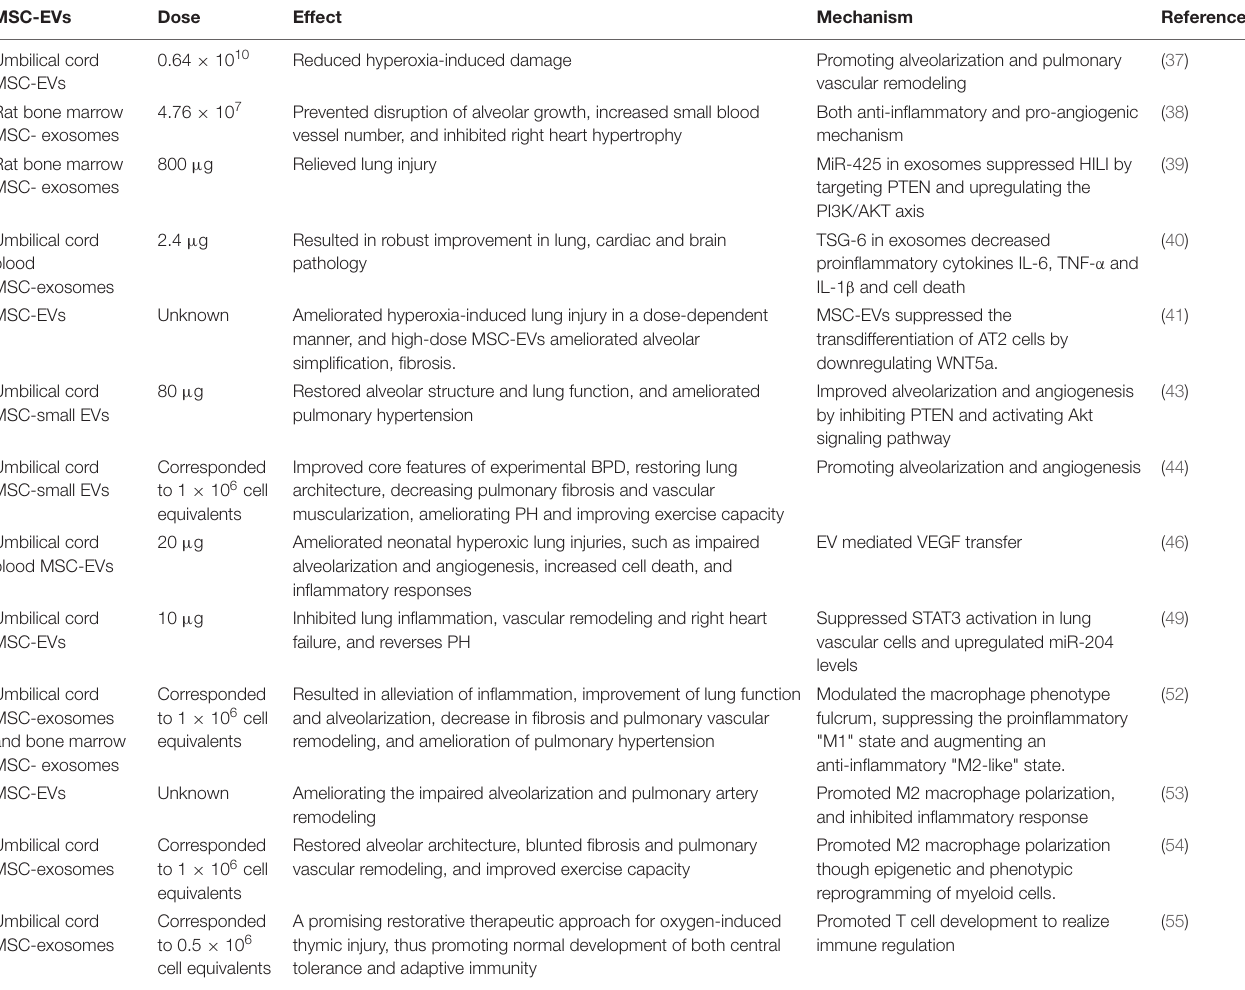
TABLE 2 | Mesenchymal stromal cells derived extracellular vesicles (MSC-EVs) treatment for hyperoxia-induced rat model of bronchopulmonary dysplasia (BPD).